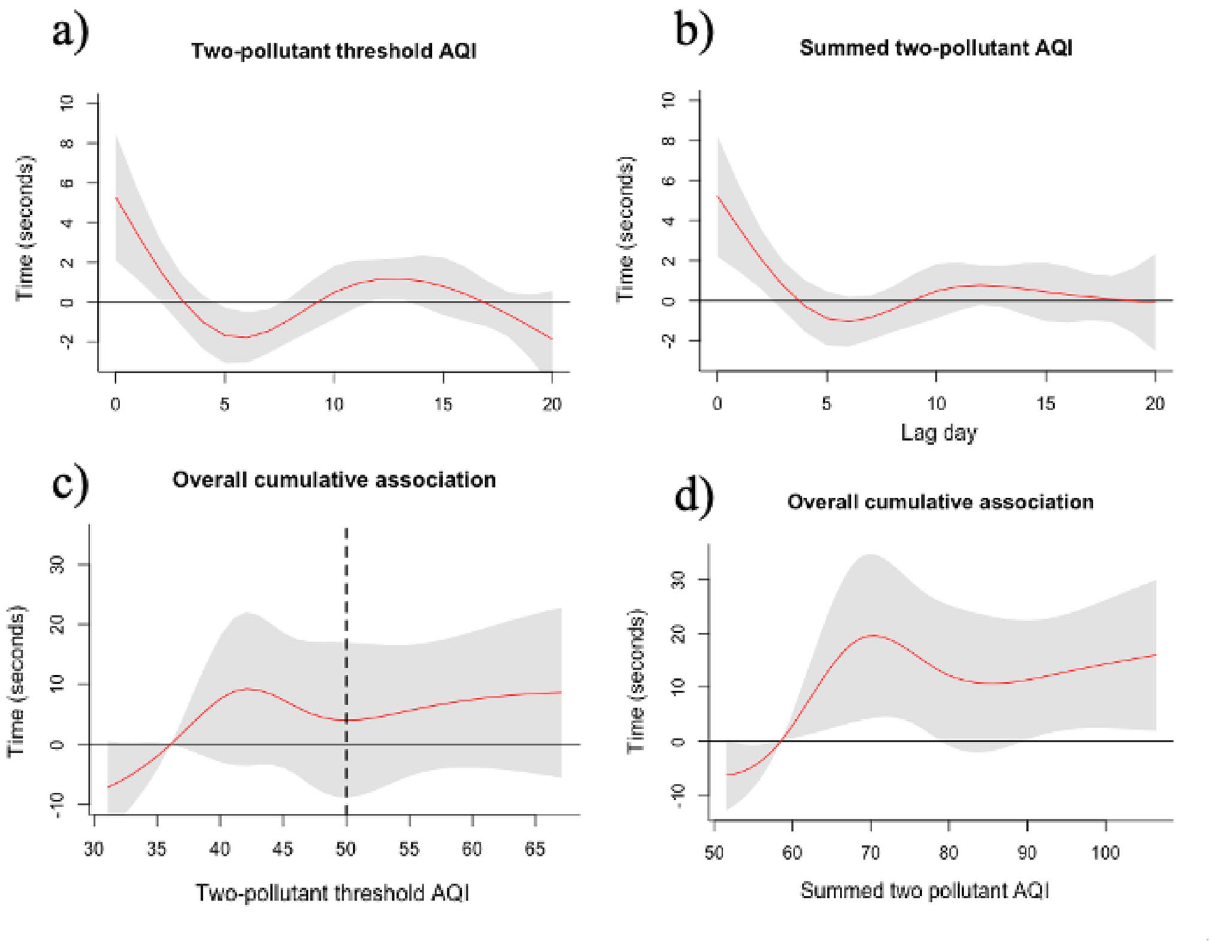
Figure 3. Two-pollutant threshold AQI ( a ) and summed two-pollutant AQI ( b ) lag-response relationship when comparing our reference levels: 20th percentile exposure with 80th percentile exposure over a 21-day training period (red line) with 95% confidence intervals (grey). Cumulative association of two-pollutant threshold AQI ( c ) and summed two-pollutant AQI ( d ) on race performance (seconds) over the 21-day training period (red line) with 95% confidence intervals (grey) and AQI good threshold (dashed black line). Software: R version 4.0.3 dlnm version